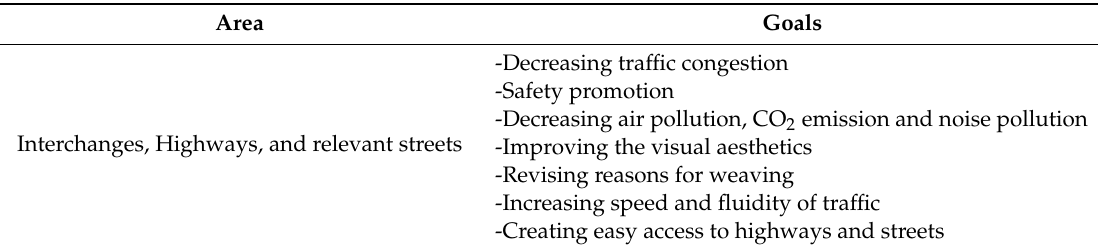
Table 2. Transportation purposes of Tehran at 2025 horizon.